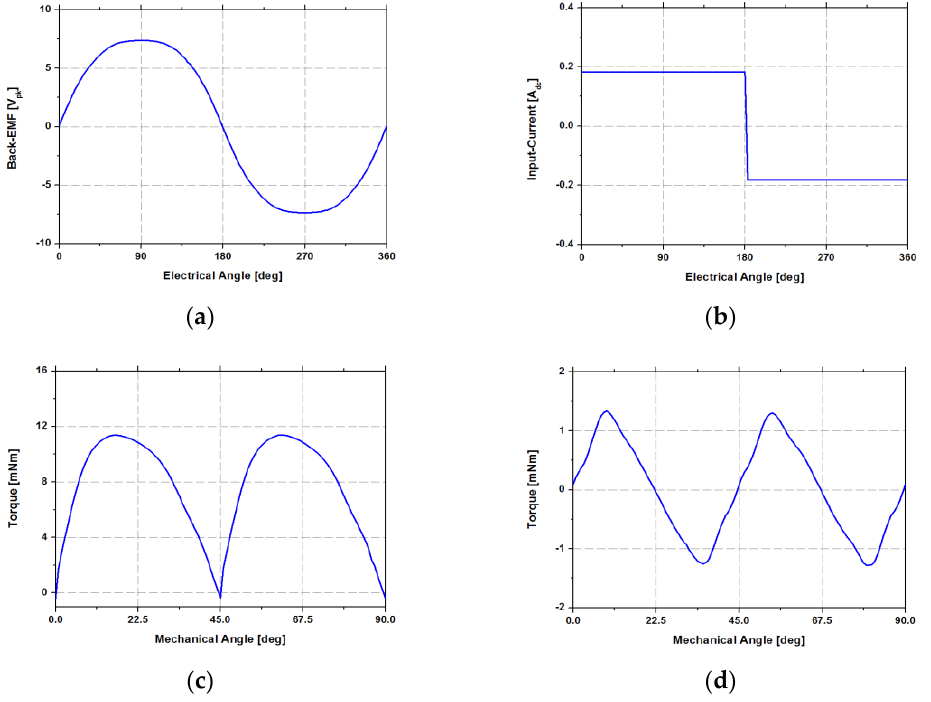
Figure 4. Current source analysis of a single-phase claw-pole motor using finite element analysis: ( a ) waveform of back-EMF; ( b ) waveform of input current; ( c ) waveform of torque; ( d ) waveform of cogging torque.